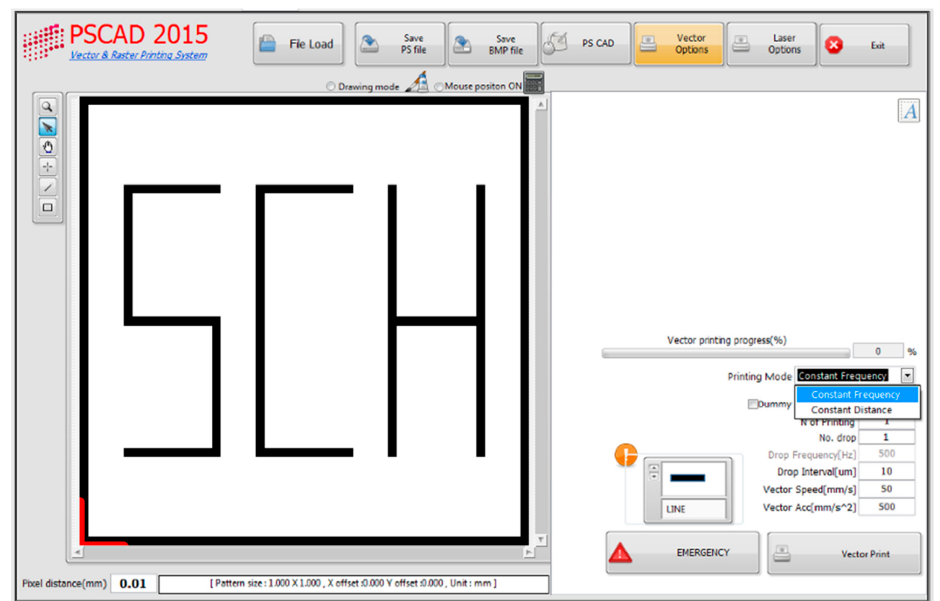
Figure 9 . Built-in CAD software that is used to implement the EPU function (Supplementary Video, Ref. [10]).